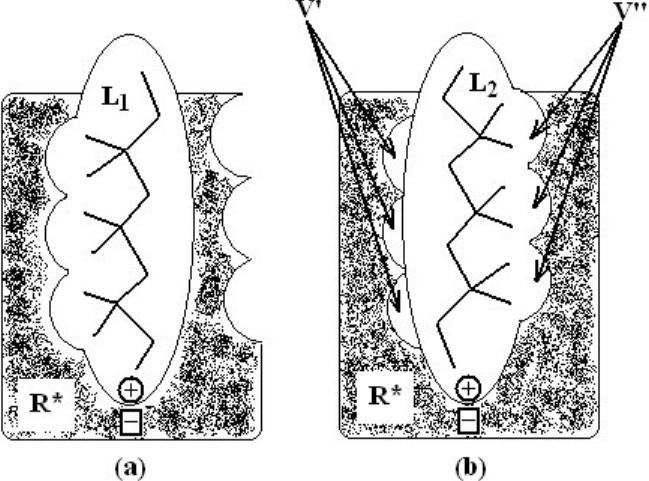
Figure 2. Schematic illustration of the MTD principle, namely the biological activity is proportional with the binding degree between the ligands (L , L ) and the receptor R: in (a) as perfect matching and 1 2 in (b) as the misfit relating the total volume